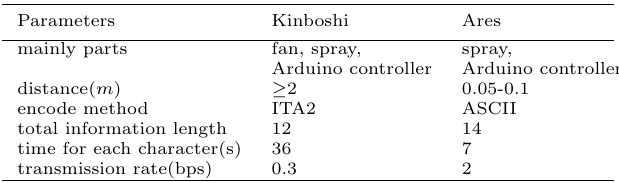
Table 1. The Comparison of Kinboshi[33] and Ares Parameters